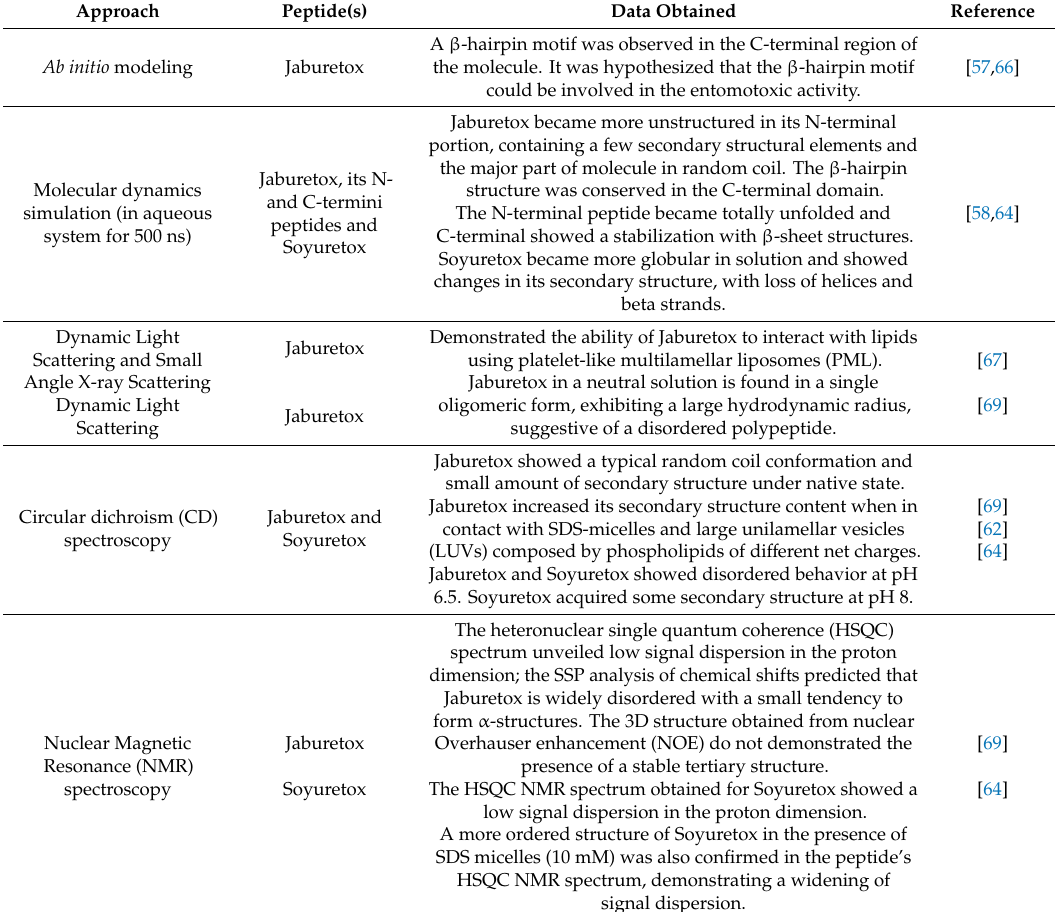
Table 1. Compiled data from structural studies of Jaburetox and